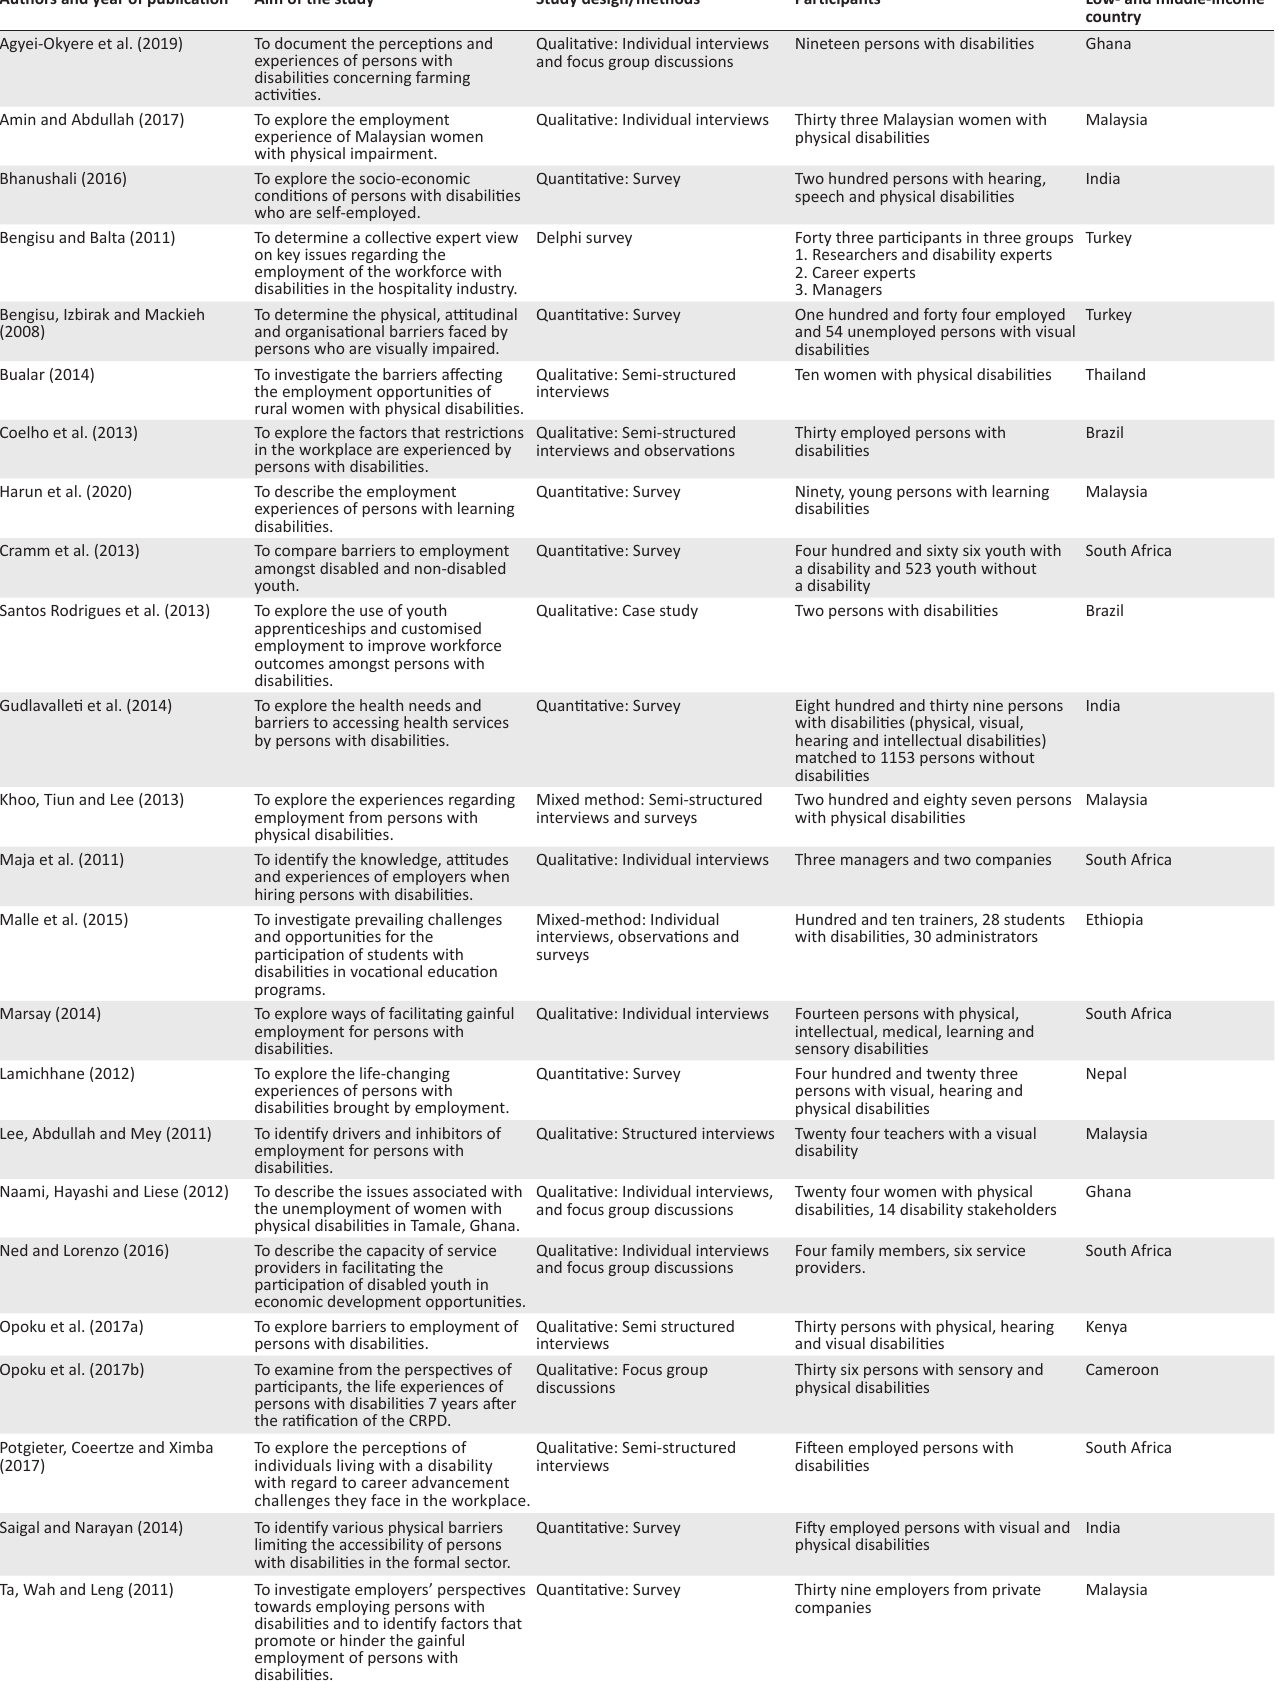
TABLE 2: Studies reporting on barriers and facilitators of employment of persons with disabilities in low- and middle-income